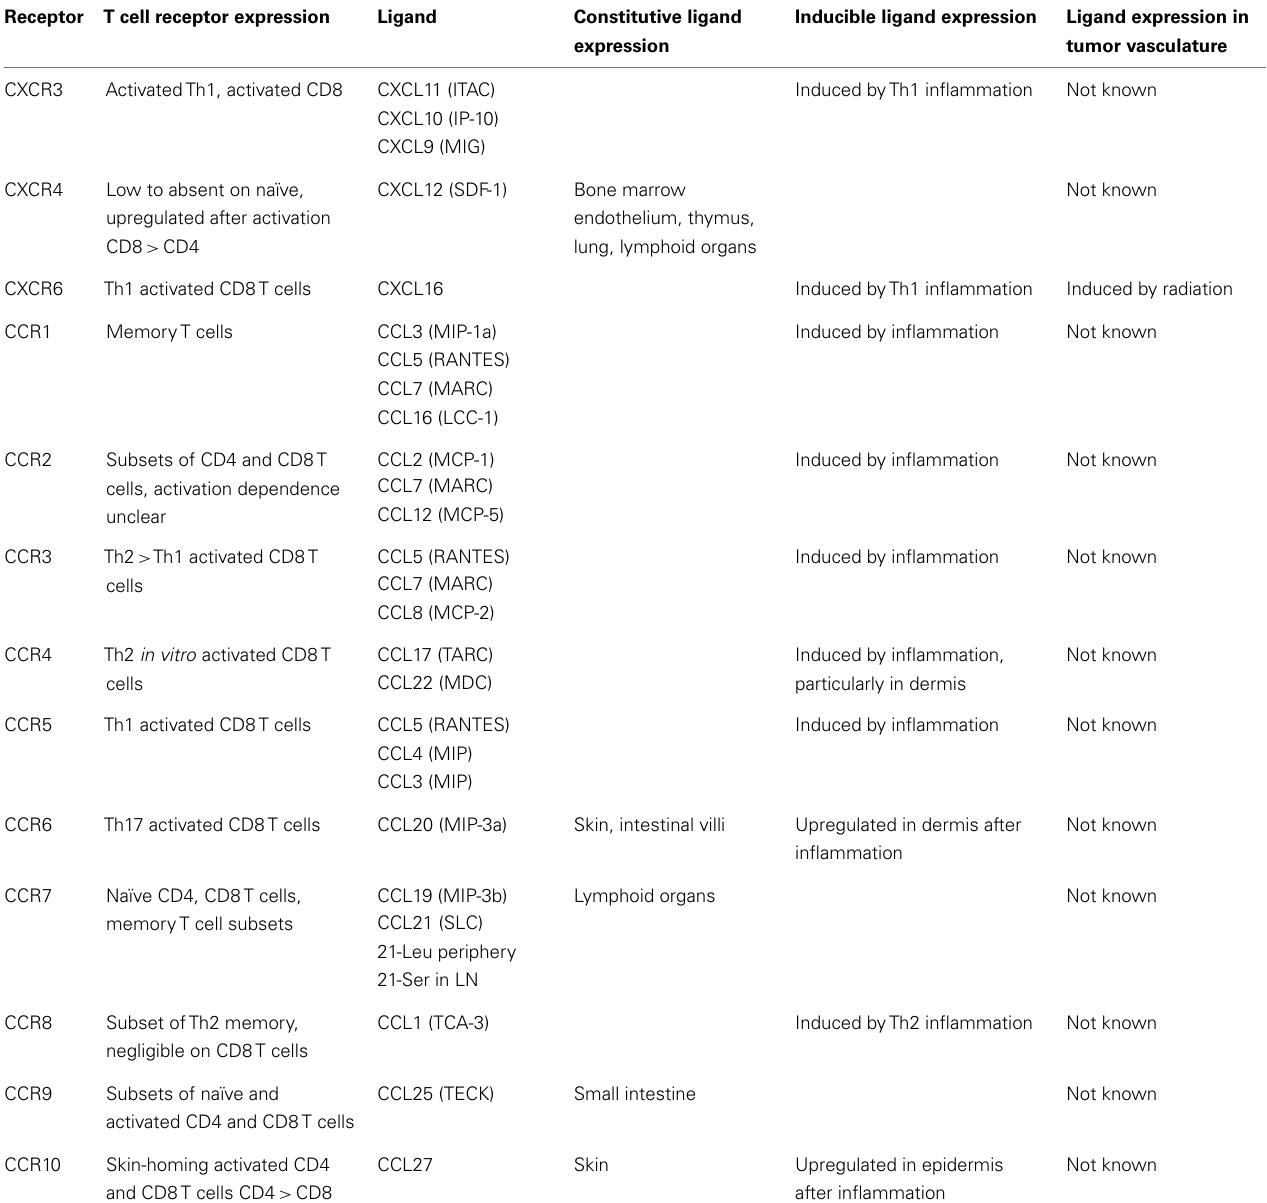
Table 2 | Chemokine receptors expressed by murineT